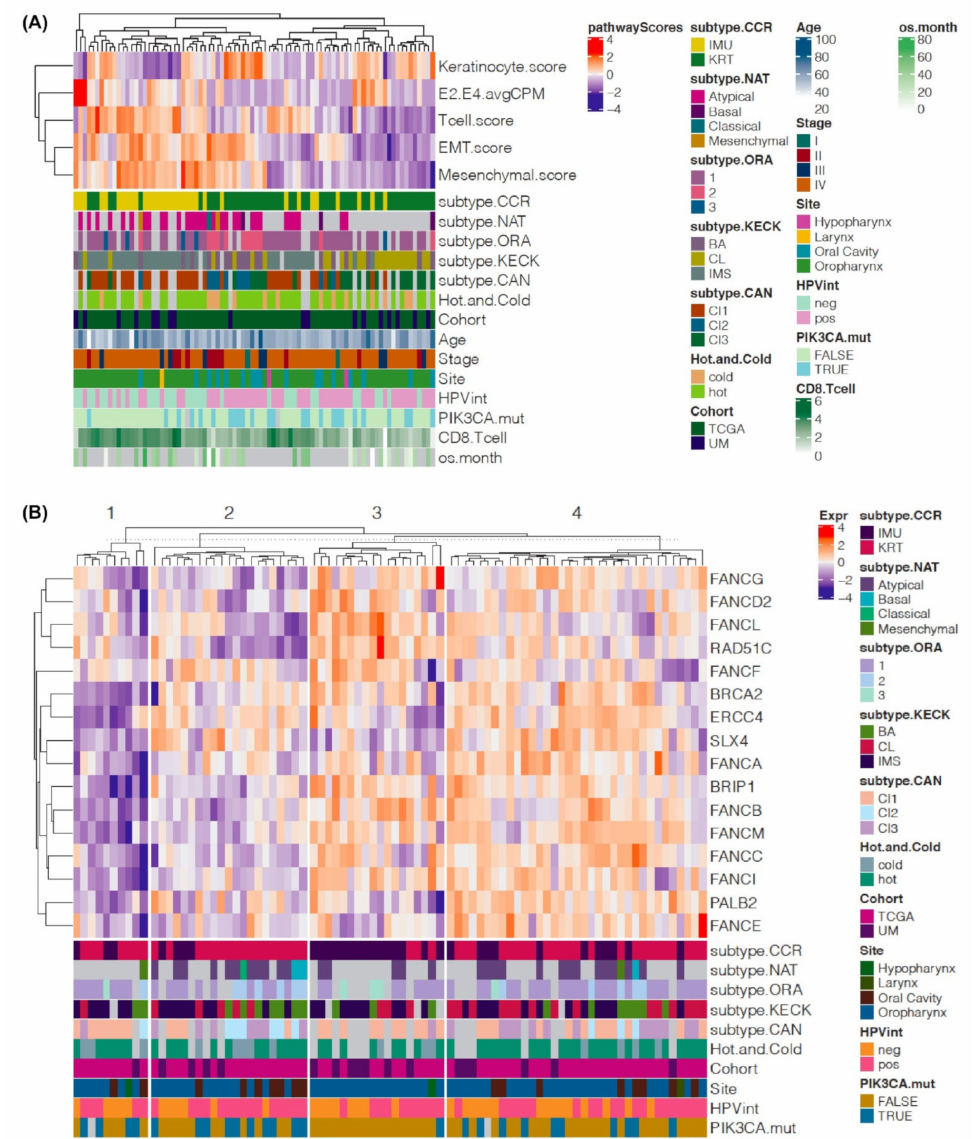
Figure 3. Clustering of the defining pathway scores and HPV scores visually distinguish the main HPV(+) subtypes. ( A ) Hierarchically clustered heatmap showing averaged HPV16 E2 and E4 expression (E2.E4.avgCPM) and pathway scores of keratinocyte differentiation (Keratinocyte.score:), T cell differentiation (Tcell.score), epithelial-mesenchymal transition (EMT.score) and mesenchymal cell differentiation (mesenchymal.score) among the 84 HPV(+) HNSCC samples from combined TCGA and UM cohorts. ( B ) Clustered heatmap based on genes in the Fanconi Anemia (FA) pathway. The 84 HPV(+) samples were clustered by K-means clustering (K = 4) based on the expression of 16 FA